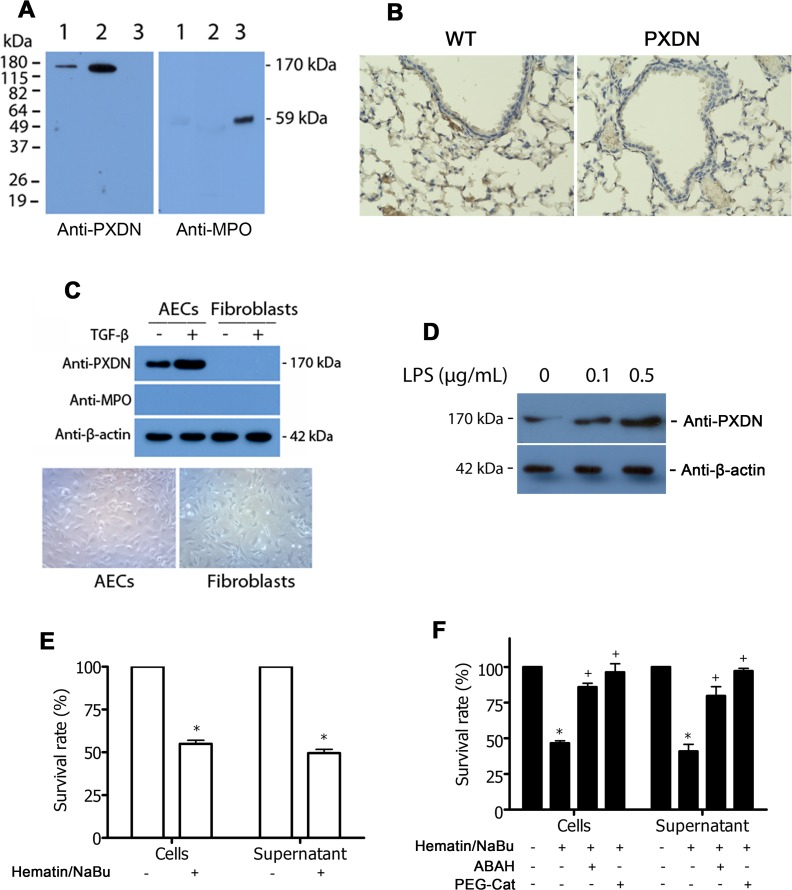
PXDN is expressed in the lung epithelium and contributes to bacterial killing.(A) Detection of PXDN in human bronchoalveolar lavage fluid (BALF). Right middle lobe BALF was collected and processed within 2 h. BALF samples were then centrifuged at 400 x g for 10 min at 4°C. BALF were concentrated by Centricon (~10x). Samples of BALF (1), positive control of human plasma containing ~100 ng of PXDN (2), and purified MPO (50 ng) (3) were subjected to immunoblotting using anti-PXDN or anti-MPO antibodies. (B) IHC of the lung. IHC of lung sections from WT and PXDN-deficient mice was performed using anti-PXDN antibody (1:600). Images were taken using BZ-X710 All-in-One Fluorescence Microscope. PXDN: dark brown. Magnification: 400x. (C) PXDN expresses in mouse primary lung type II alveolar epithelial cells (AECs). Upper panel showed immunoblot analysis of AECs and fibroblasts while lower panel showed phase contrast microscopy of AECs (left) and fibroblasts (right); magnification 100x. Cell lysates were subjected to conventional immunoblotting by using anti-PXDN antibody. β-actin was used as loading control. (D) LPS induces PXDN expression. AECs were induced by LPS as indicated. The cell lysates were subject to immunoblot analysis as in (C). (E) Mouse primary type II AECs mediate P. aeruginosa killing. AECs were grown in 12-well plate in DMEM with 10% FBS without antibiotics until 70% confluence. Cells were serum-starved for 16 h prior to bactericidal assays; cells were stimulated with/without TGF-β and hematin/NaBu. Cells and the overlying medium (supernatant) were separated and utilized for evaluation of PXDN-mediated bactericidal killing. 1 mL of fresh DMEM containing 104
P. aeruginosa strain K and 10 μM H2O2 was added to AECs or supernatant. The mixture was incubated at 37°C for 1 h, and then plated on LB agar plates prior to overnight incubation at 37°C. The control group contained untreated AECs and P. aeruginosa. The relative survival rate was calculated as CFUs in the experimental group divided by those in the control group; *P< 0.001 vs. Control. (F) Inhibition of AEC-mediated P. aeruginosa killing by peroxidase inhibitors. The experiments were carried out as in “E” with addition of ABAH (broadly specific inhibitor of heme-containing peroxidases) or PEG-catalase (which reduces H2O2). *P< 0.001 vs. Control; +P < 0.001 vs. hematin/NaBu. Data are representatives of three independent experiments.